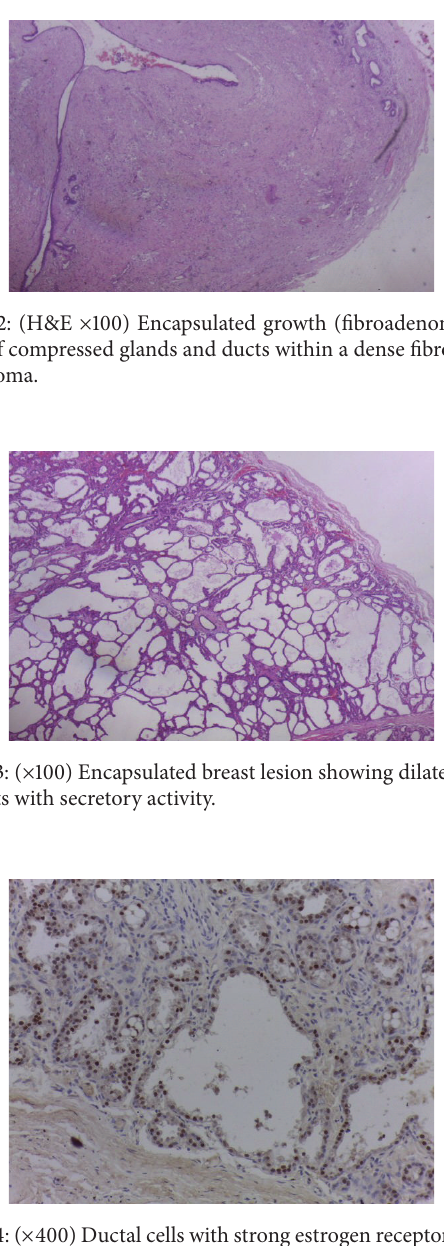
Figure 5: ( × 400) Ductal cells with weak progesterone receptor